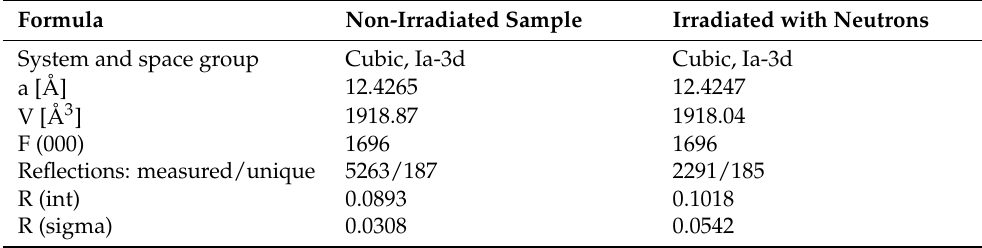
Table 1. Crystallographic parameters of Nd:GSAG crystal before and after irradiation with neutrons.